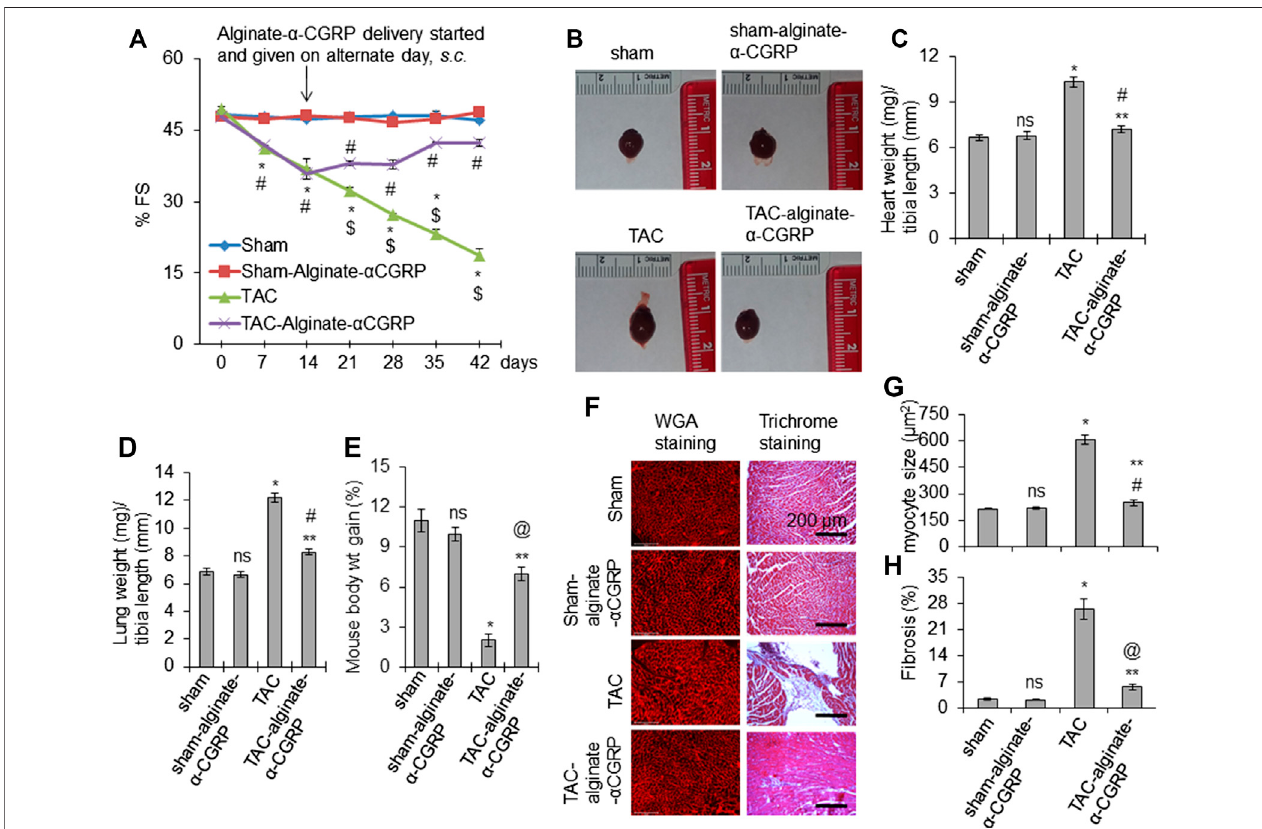
FIGURE 6 | Alginate- α -CGRP microcapsule administration in 15-days post-TAC mice improves cardiac functions. (A) Graph showing % FS in sham, sham- alginate- α -CGRP, TAC-only, and TAC-alginate- α -CGRP groups of mice. After 15 days of TAC, alginate- α -CGRP microcapsules containing α -CGRP doses of 6 mg/kg/ mouse were injected on alternate days, untilday 28. Echocardiography wasperformed at differenttime points and %FS wasplotted asmean ± SEM. * p < 0.05, TAC vs sham at the same time point; # p < 0.05, TAC-alginate- α -CGRP vs sham at the same time point; $ p < 0.05, TAC vs TAC-alginate- α -CGRP at the same time point. (B) Representative images showing the size of hearts after 28 days of delivery of alginate- α -CGRP microcapsules. Ratio of wet heart weight/tibia length was plotted as mean ± SEM (C) . (D) Bar diagram showing ratio of wet lung weight/tibia length as mean ± SEM. (E) Bar diagram showing mice weight gain (in percentage) during the course of the experiment as mean ± SEM. p < 0.05 was considered signi fi cant. * p < 0.05, TAC vs sham; ** p < 0.05, TAC-alginate- α -CGRP vs TAC; # p > 0.05, TAC- alginate- α -CGRP vs sham; @ p < 0.05, TAC-alginate- α -CGRP vs sham; ns, not-signi fi cant compared to sham. (F) Representative histology images showing the size of cardiomyocytes (WGA staining) and level of fi brosis (trichrome-collagen staining) in the LVs from different groups of mice. Cardiomyocyte size (G) and % fi brosis (H) in LVs were quantitated using the NIH-ImageJ software and plotted as mean ± SEM. p value < 0.05 was considered signi fi cant. * p < 0.05, TAC vs sham; ** p < 0.05, TAC- alginate- α -CGRP vs TAC; # p > 0.05, TAC-alginate- α -CGRP vs sham; @ p < 0.05, TAC-alginate- α -CGRP vs sham; ns (cid:1) not-signi fi cant compared to